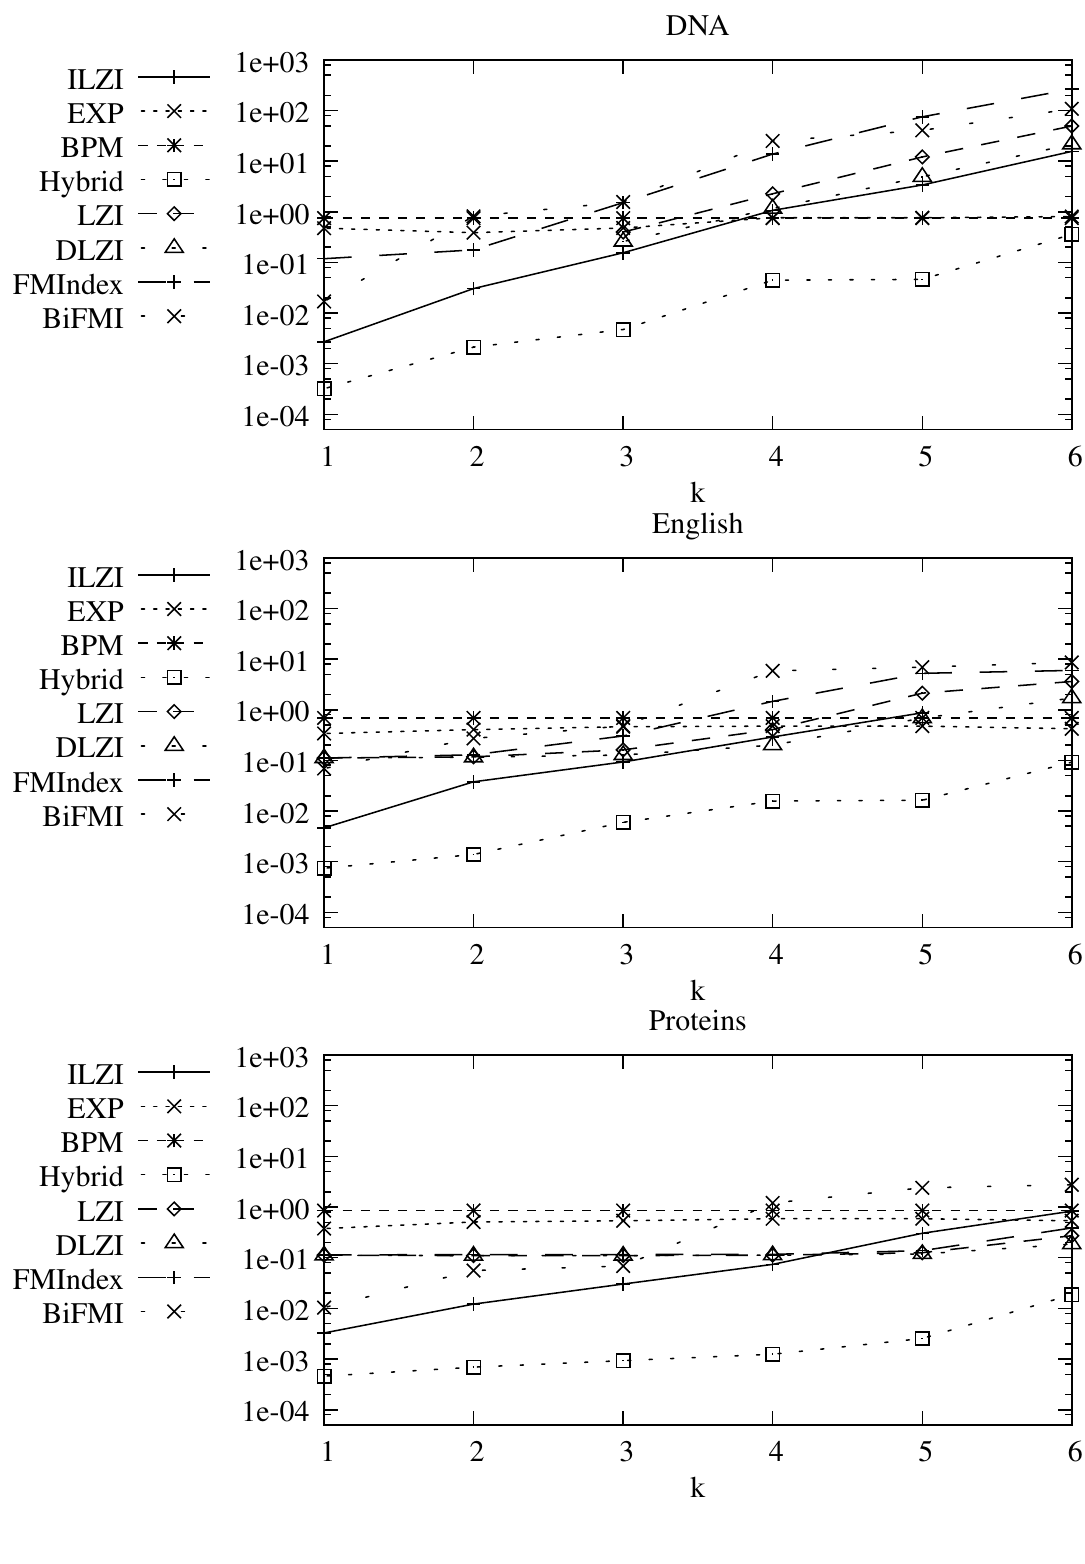
Figure 8. Average user time for finding the occurrences of patterns of size 30 with k errors in DNA, English, and Proteins. The y axis units are in